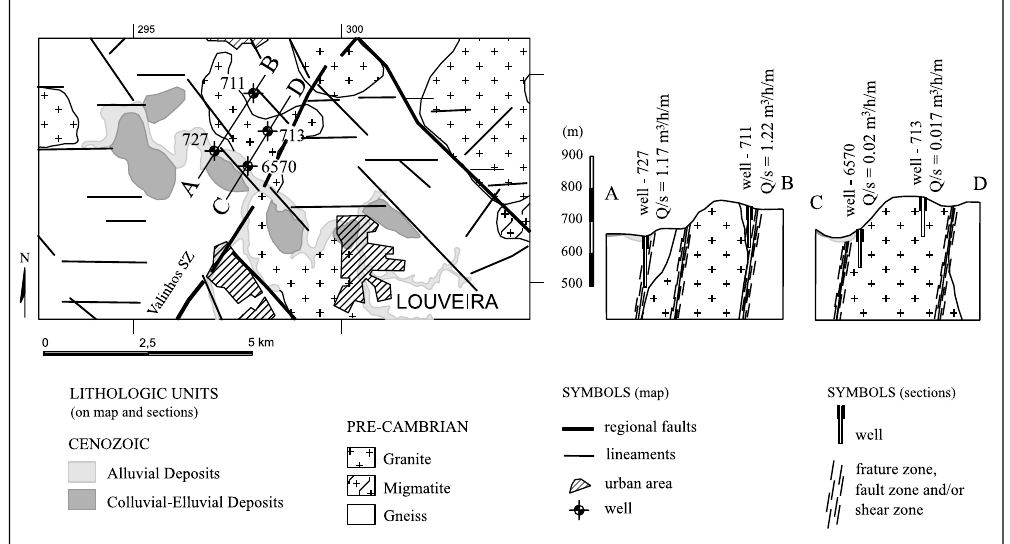
Fig. 10 – The third case study, in the proximities of Louveira, where wells with high productivity are associated to structural sheaves with NW–SE and E–W